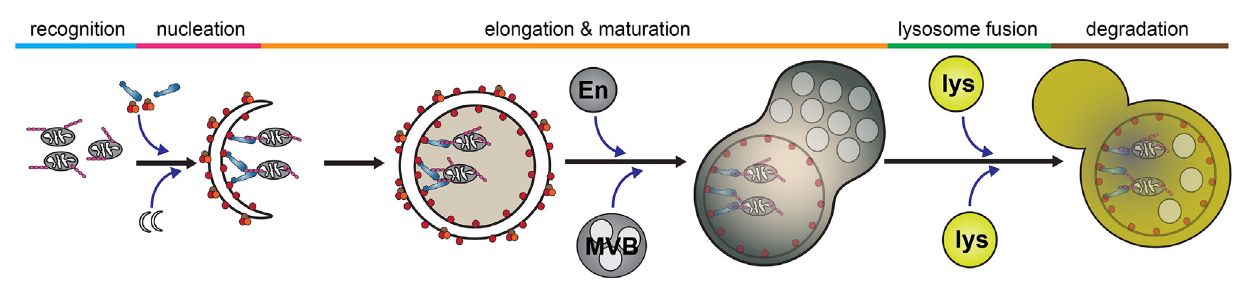
FiGURe 2 | Selective autophagy. The autophagy pathway can be divided into five major steps: cargo recognition, phagophore nucleation, autophagosome elongation and maturation, fusion with the lysosome, and cargo degradation. Initial steps of cargo identification, as which occurs during mitochondrial capture, requires ubiquitination of a substrate and identification by autophagy receptors, such as optineurin, which facilitates the recruitment and nucleation of autophagosomal membrane to encapsulate the cargo. Subsequently, the autophagosome undergoes maturation following fusion with various endosomal vesicles and eventually fuses with the lysosome to facilitate cargo degradation. Abbreviations: En, endosome; MVB, multivesicular body; lys,